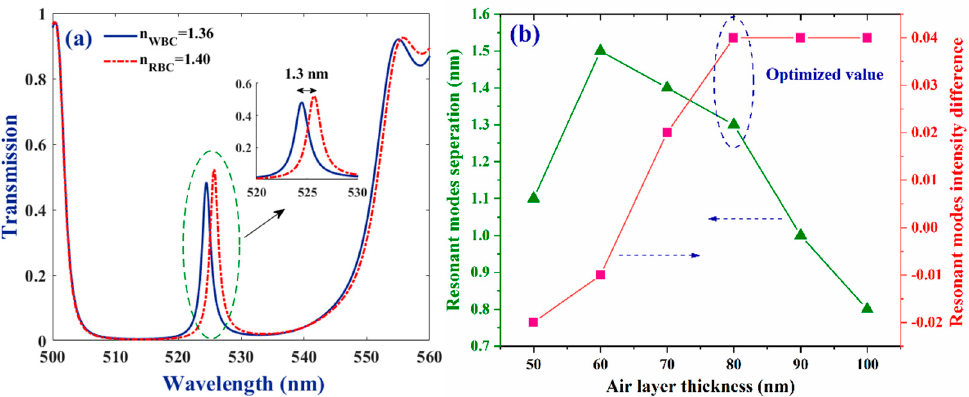
Figure 3. ( a ) Transmittance spectra of the bio-chip when bio-cell is capsulated in air slabs of d air = 80 nm. ( b ) Dependence of the separation of the resonant modes’ central wavelength and their intensity difference (I RBC –I WBC ) on the thickness of the air gaps. Number of periods of the unit-cells at the sides of the bio-cell is 3 and other parameters are considered the same, as presented in caption of Figure 2.